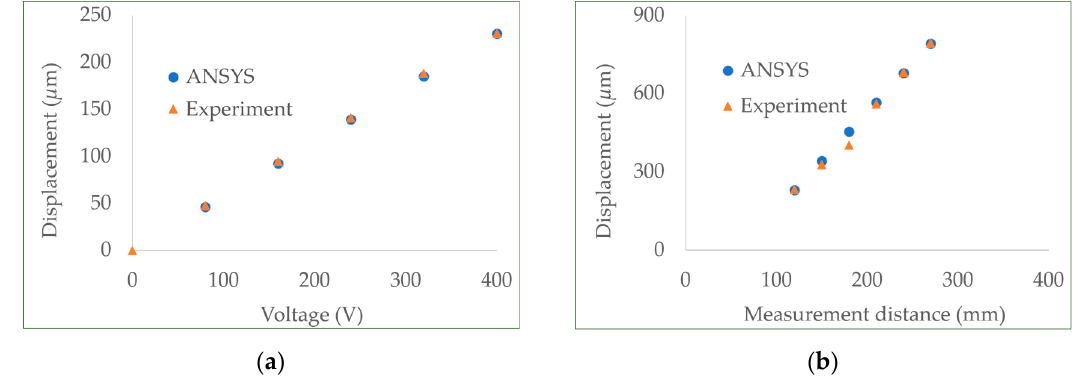
Figure 8. Comparison of the results from the homogenized PFP bending test. ( a ) The measurement point location was fixed, and the applied voltage was changed; ( b ) The applied voltage was fixed and the measurement distance was changed. The blue dots show the simulation results and the orange triangles show the corresponding experimental results [31].